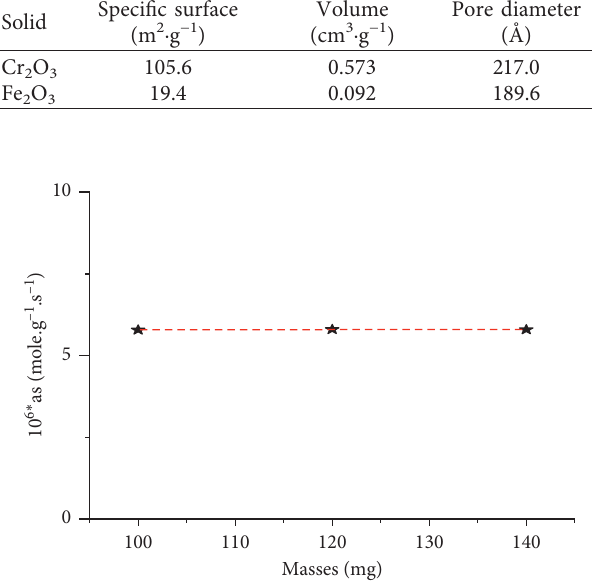
Figure 4: Effect of catalyst masses on the specific